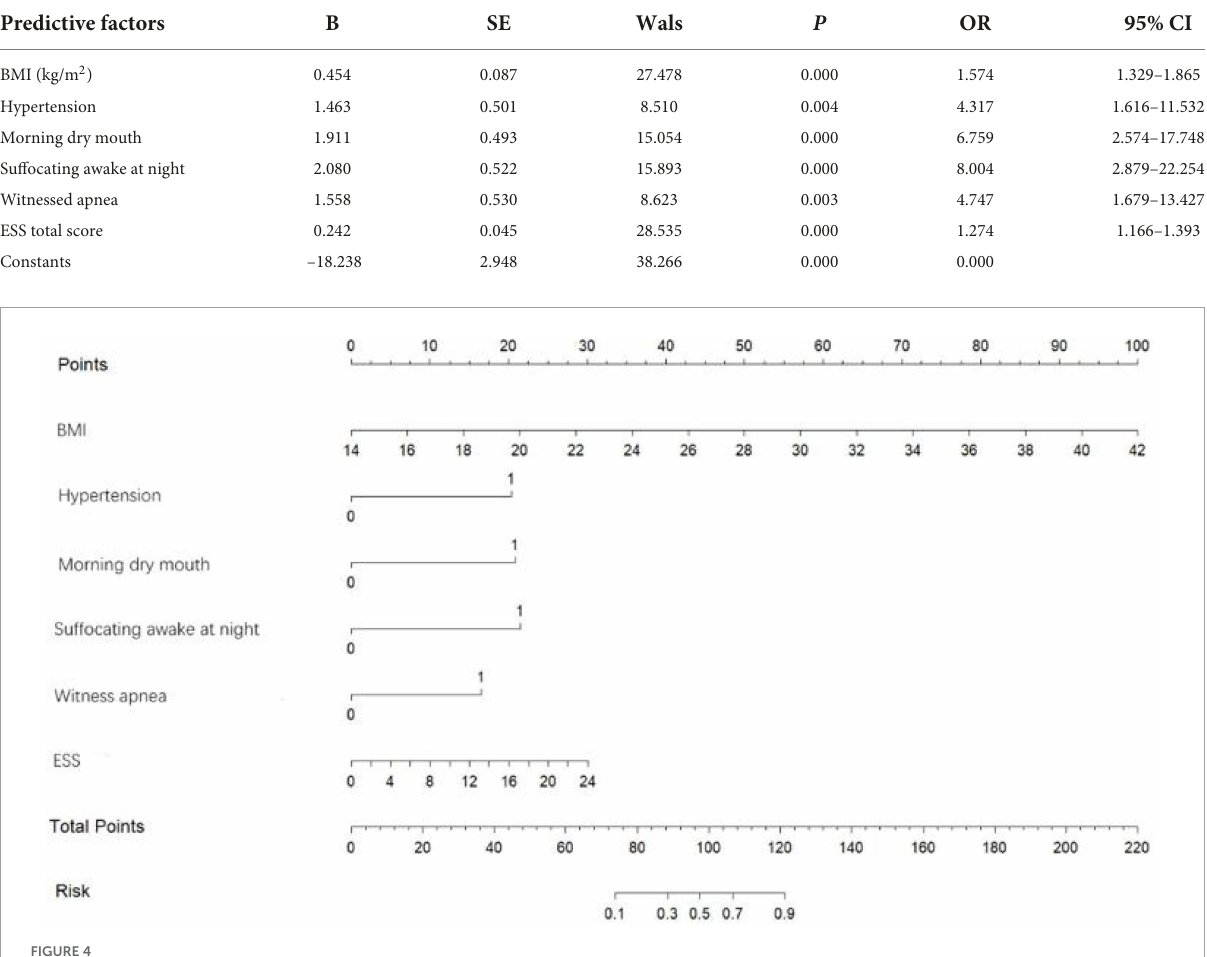
FIGURE4 Predicting the risk of moderate-to-severe OSA in the nomogram.